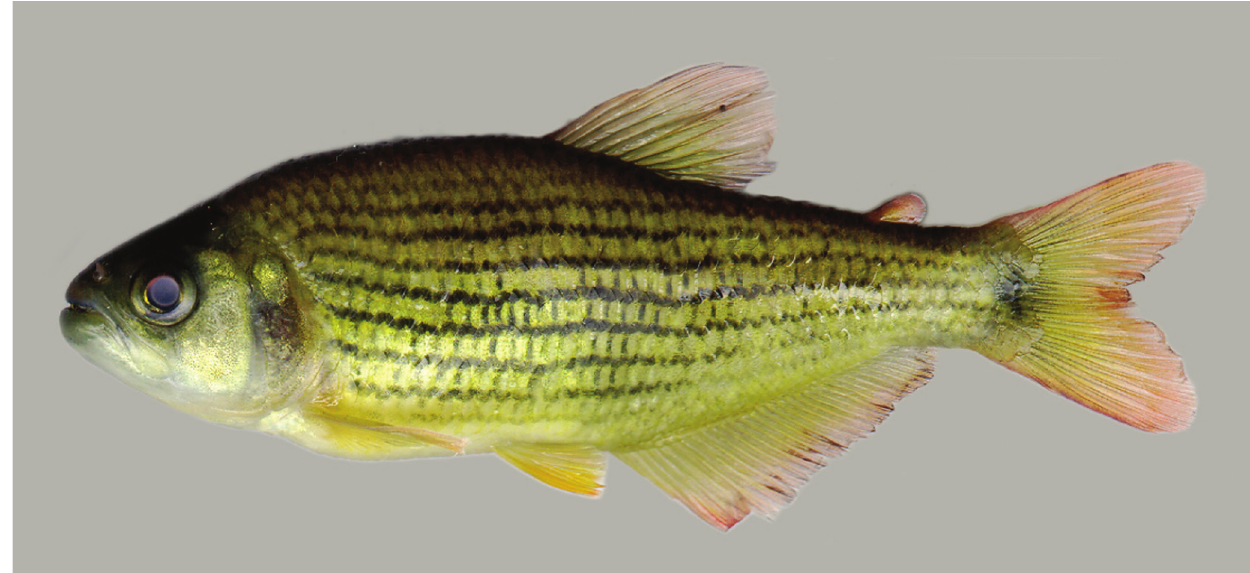
Fig. 2. Hollandichthys taramandahy , MCP 29243, paratype, female, 71.9 mm SL, rio Mampituba, Praia Grande, Santa Cata- rina, Brazil. Photo taken just after fixation in